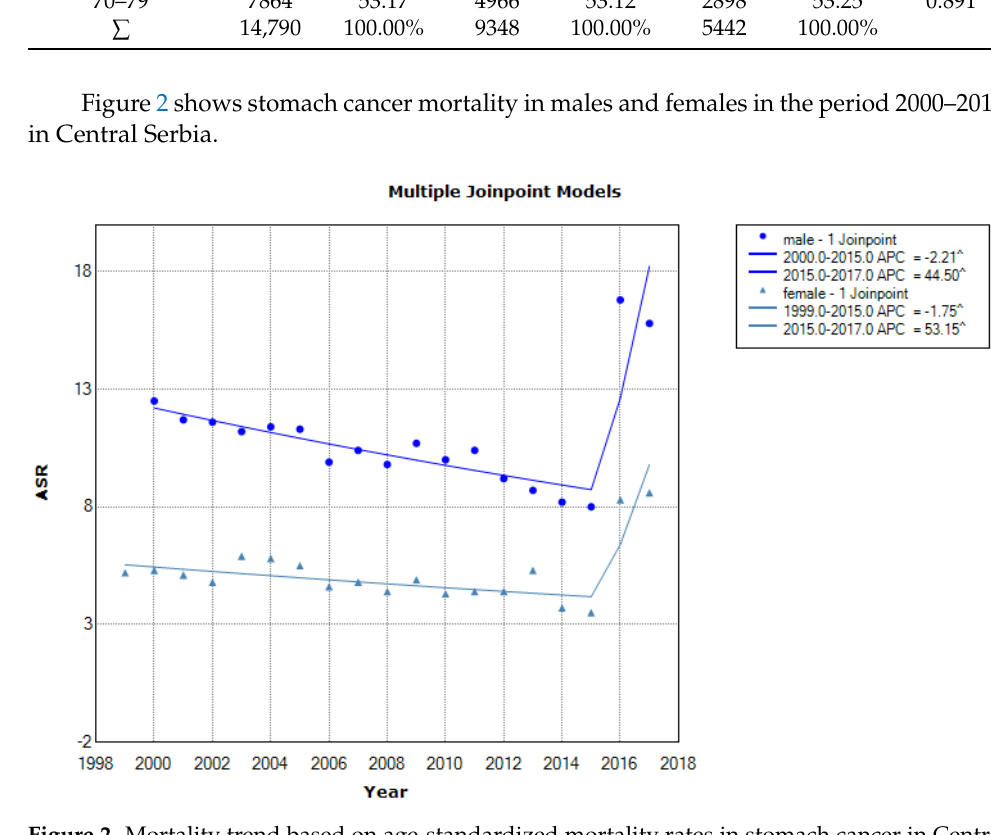
Figure 2. Mortality trend based on age-standardized mortality rates in stomach cancer in Central Serbia according to sex in the period from 2000–2017 with annual percentage change (APC). Joinpoint regression analysis showed a significant decrease in stomach cancer